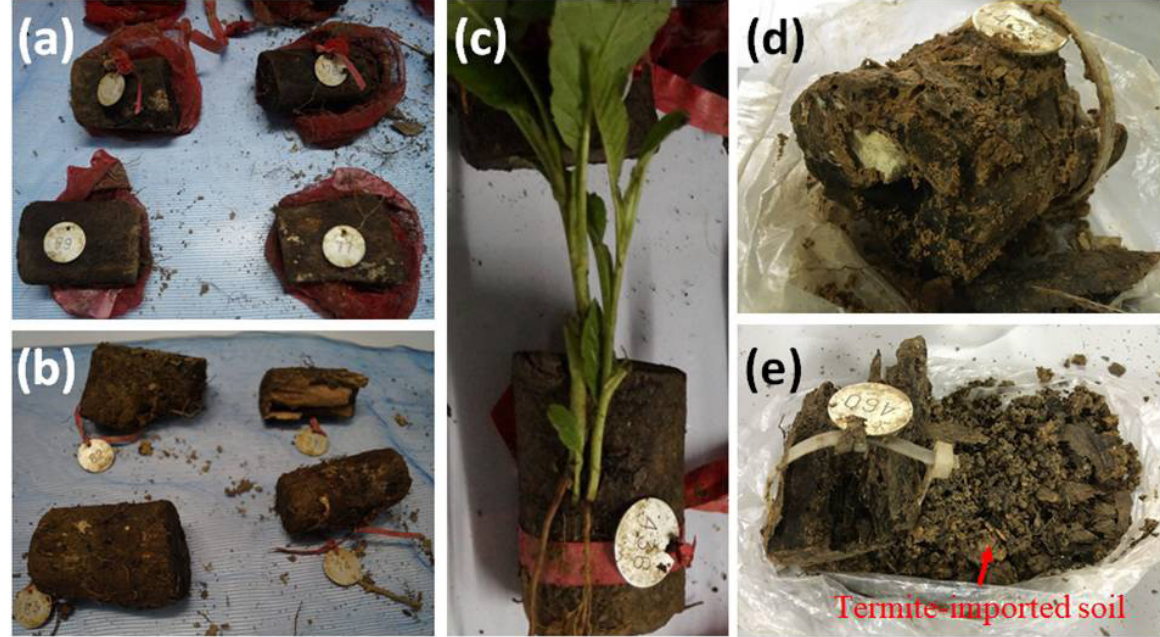
Fig 2 . Photographs of an air-dried (a) mesh bag samples and (b) control samples, and (c) a resprout in a control sample, and control samples (d) before removing termite-imported soils, and (e) after removing the